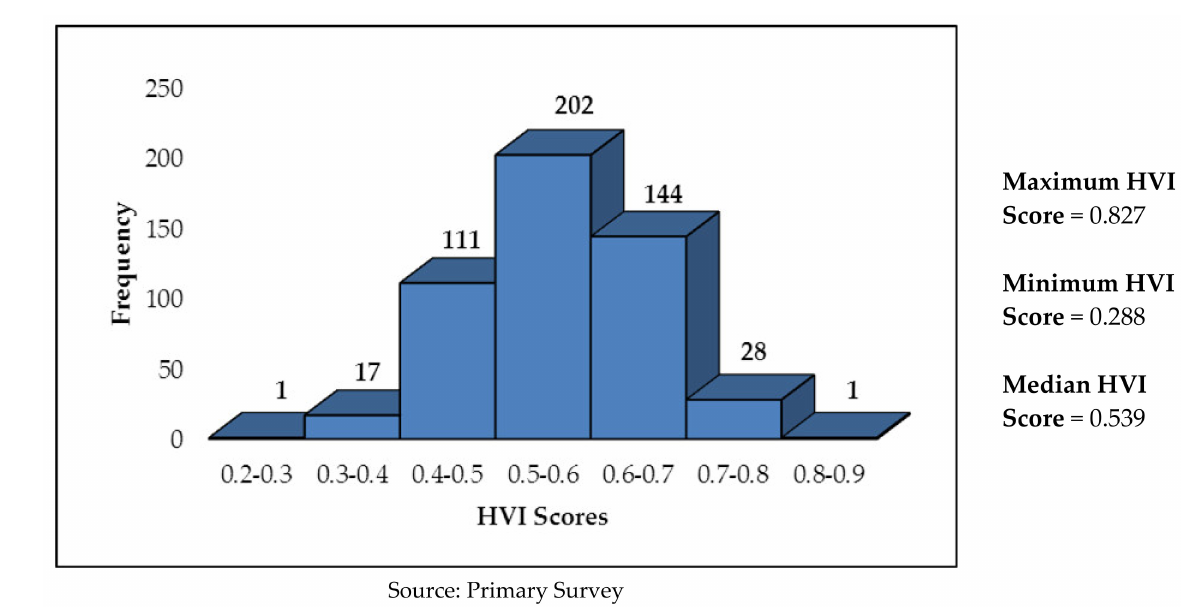
Figure 3. Pictorial Distribution of No. of Households by HVI Scores in Ongole.